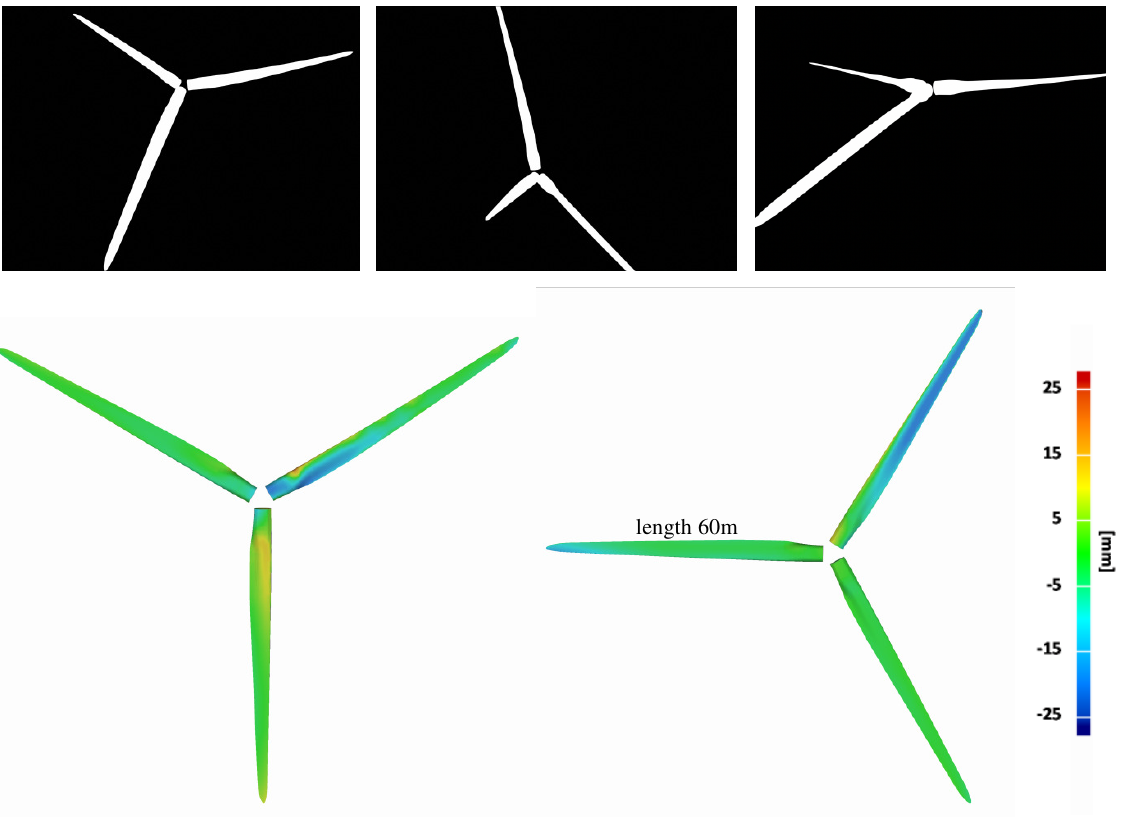
Fig. 3: Example images of the sequence (top) and comparison between the determined (deformed) shape and the given shape from simulation after 2 sec and 4 sec